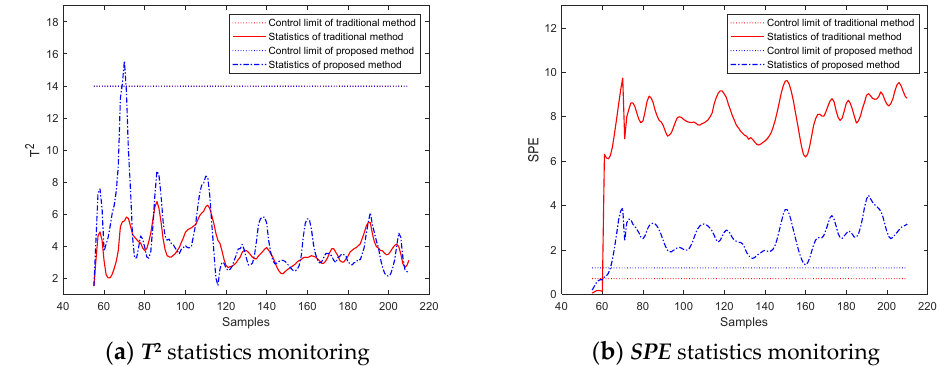
Figure 18. Multi-mode online monitoring of material disturbance fault.